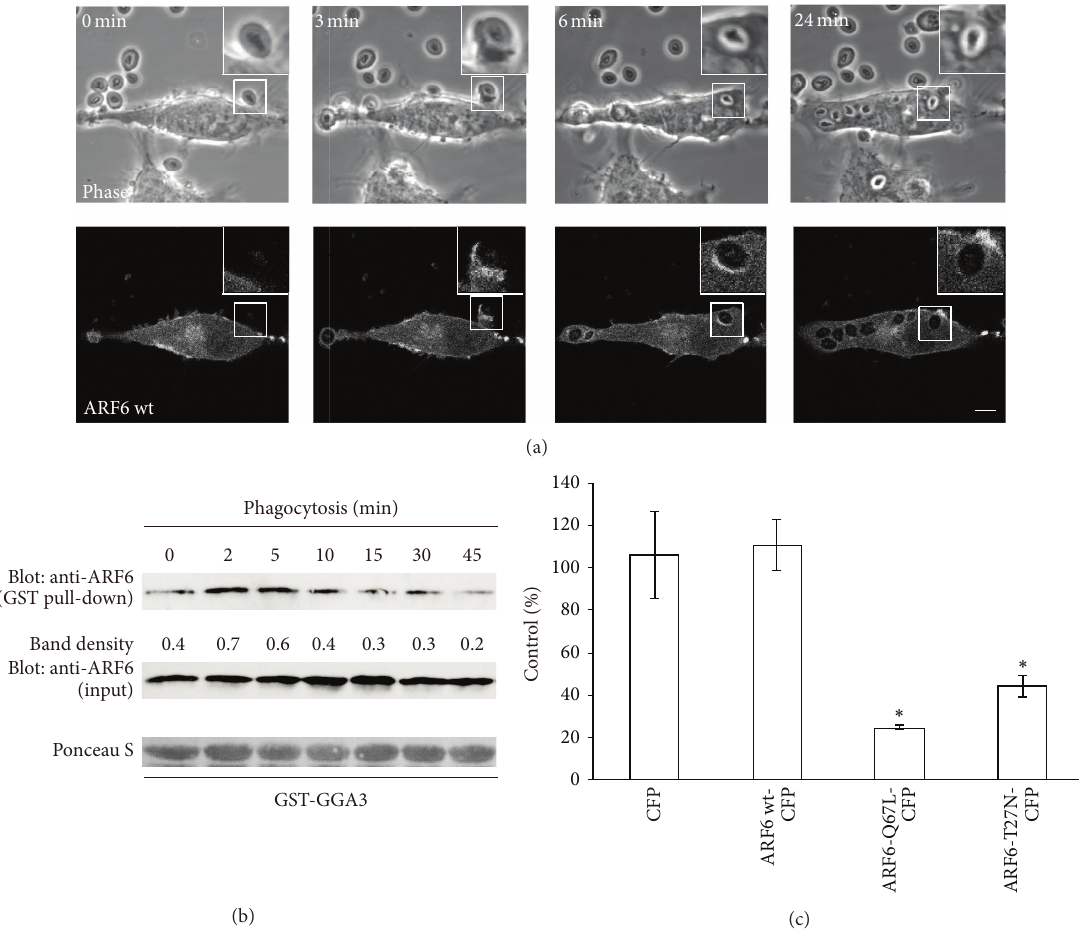
Figure 7: ARF6 is transiently activated and regulates uptake of zymosan particles. (a) Live-cell imaging of RAW264 macrophages expressing ARF6-wt-CFP during the phagocytosis of zymosan. The elapsed time is indicated at the top. The insets show higher-magnification images of the indicated regions of the cells. Phase-contrast images are shown (upper panels). Scale bar: 5 𝜇 m. (b) RAW264 cells were incubated with zymosan for various times. Cell lysates were incubated with GST-GGA3. The proteins associated with GST-GGA3 were pulled down using glutathione-sepharose beads and analyzed by western blotting (top panel). The middle panel shows aliquots of total lysates. The density of the protein bands was measured. The relative protein band intensity of GTP-ARF6 was normalized to total ARF6 (GTP-bound plus GDP-bound forms). (c) RAW264 cells transiently expressing CFP, ARF6-wt-CFP, ARF6-Q67L-CFP, or ARF6-T27N-CFP were incubated with zymosan and then fixed. The efficiency of phagocytosis was calculated. The results are expressed as a percentage of control (untransfected) cells. The means ± SEM of three independent experiments are plotted. Student’s 𝑡 -test was used for statistical analysis. ∗ 𝑝 < 0.05 compared to CFP transfected